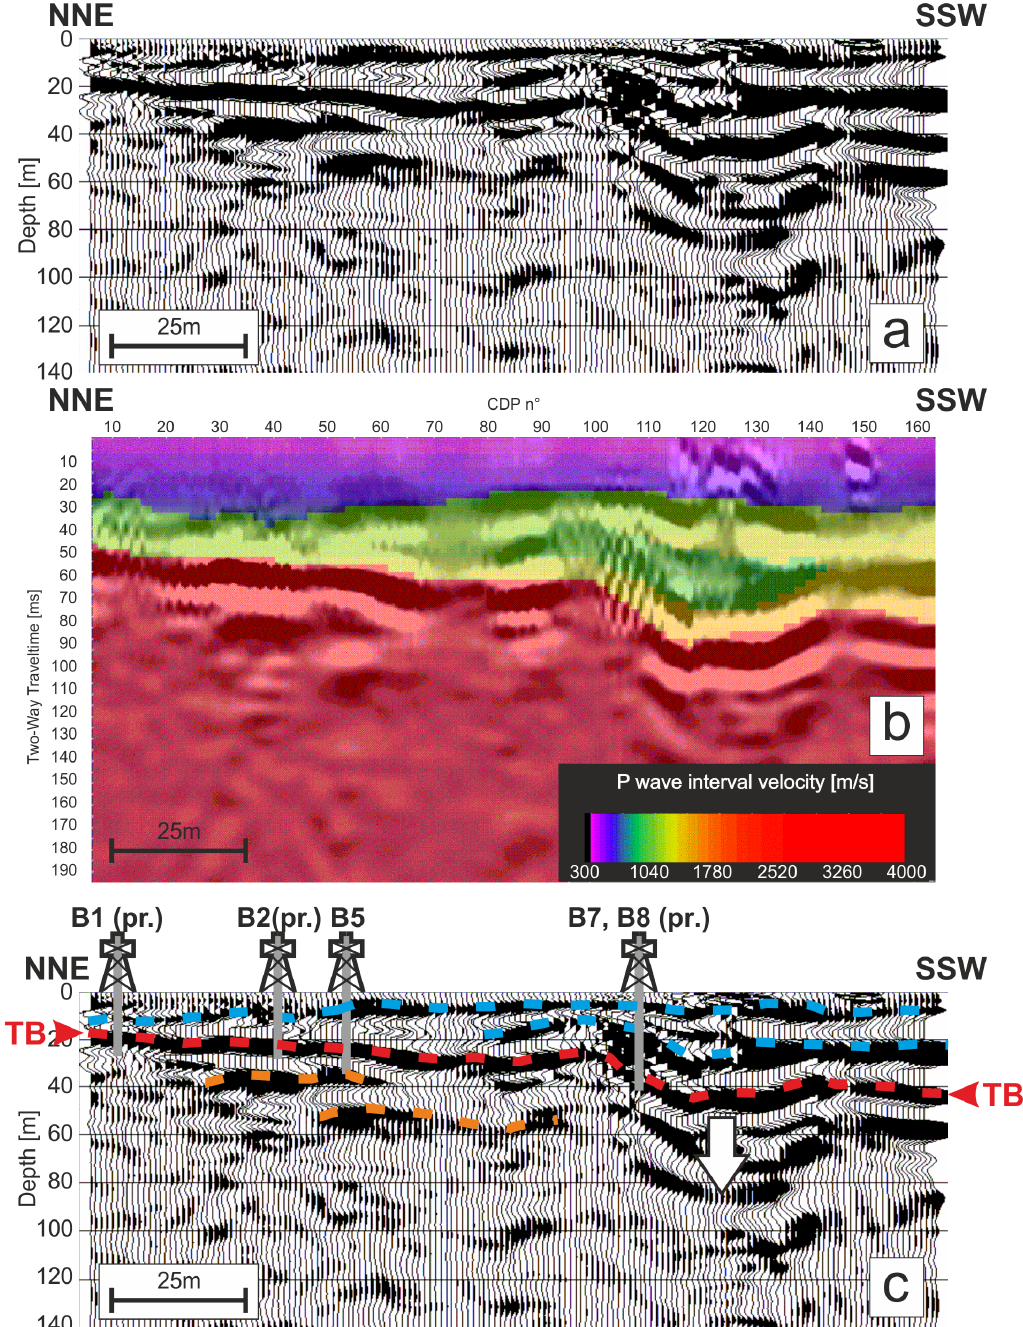
Figure 8. Reflection seismic profile PS1. ( a ) Processed depth converted profile; ( b ) TWT profile with the interval velocity superimposed; ( c ) interpreted depth converted profile. The red dashed line marks the top of the bedrock (TB), while light blue and orange lines highlight seismic horizons within the sediments and within the evaporites, respectively. While the arrow is located where the deformation reaches the maximum. The location and depth of boreholes B1, B2, B5, B7 and B8 used for validation are also provided (Figure 6).